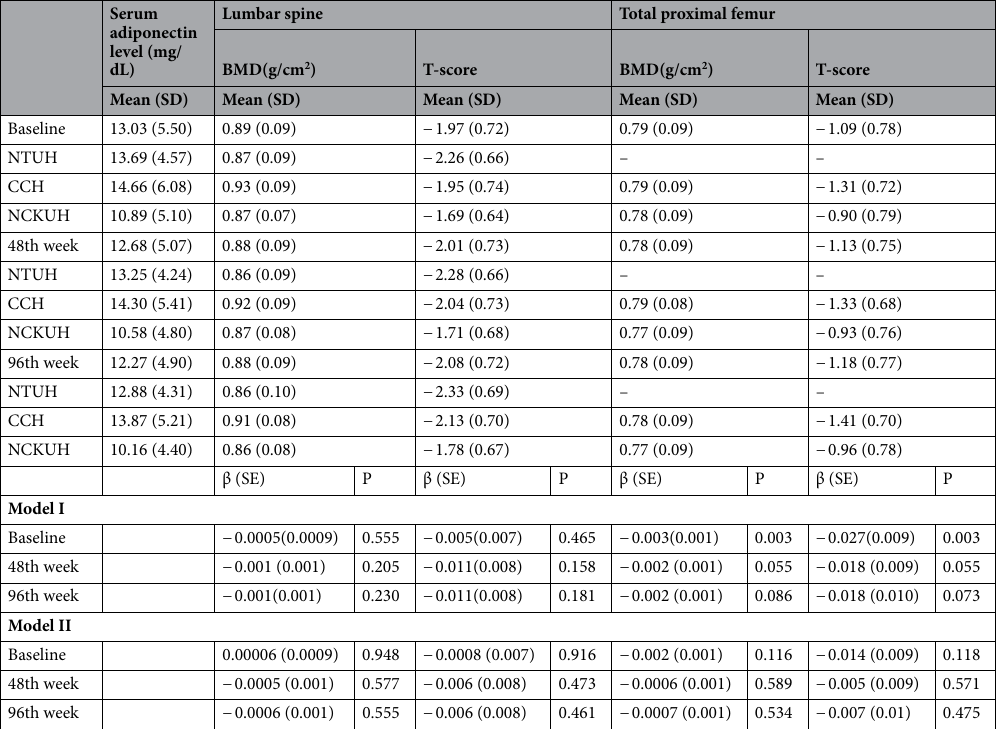
Table 2. The association between serum adiponectin levels and lumbar spine/total proximal femur BMD at three time points using simple linear regression models. Model I: adjusted for age, isoflavone treatment, hospital sites, history of diabetes, hypertension and hyperlipidemia as well as average total METs spent and total calories consumed. Model II: Model I plus body mass